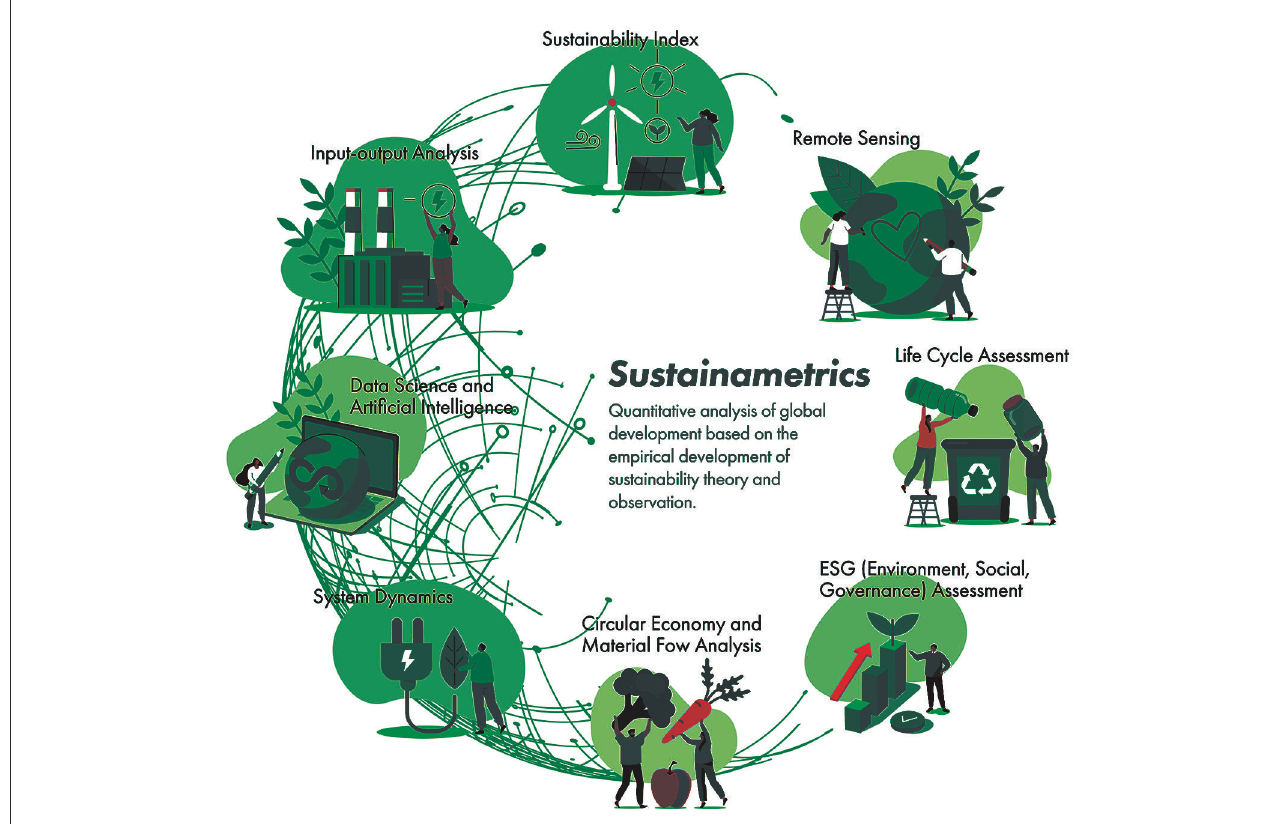
FIGURE1 Sustainametrics -envisioning a sustainable future with data